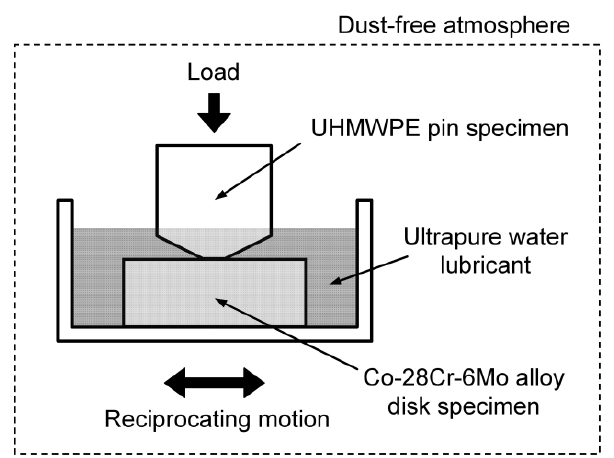
Fig. 1 A schematic drawing of the transfer test apparatus.